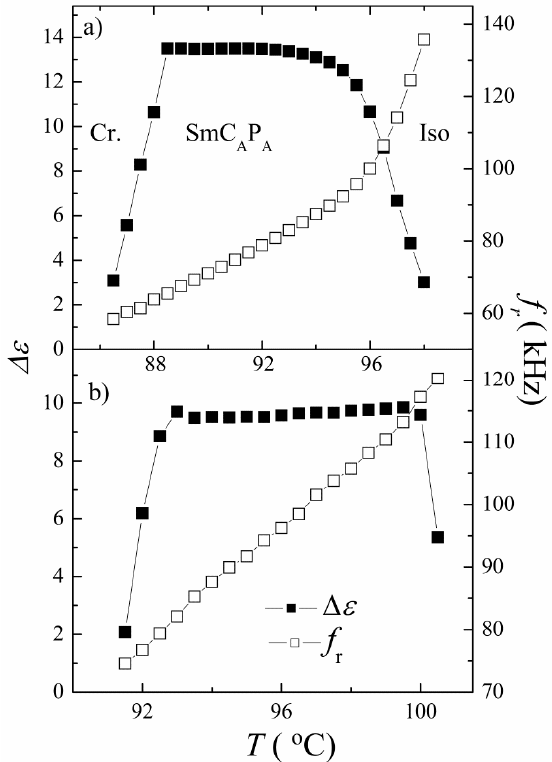
Figure 7. Temperature dependencies of the relaxation frequency, f r , and the dielectric strength, Δε , in the SmC A P A phase for ( a ) Ic , and ( b ) Id .